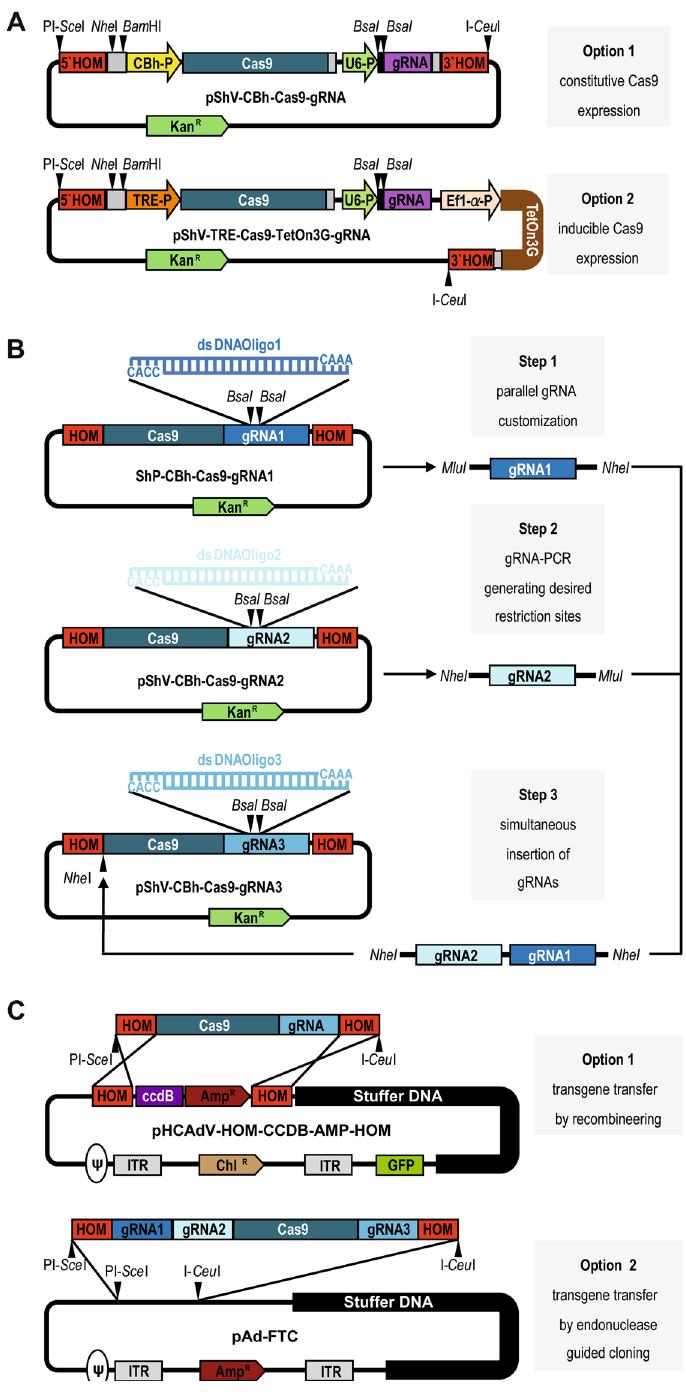
Figure 1. Plasmid toolbox for the construction of CRISPR/Cas9-HCAdV genomes. ( A ) Schematic presentation of intermediate CRISPR/Cas9 shuttle plasmids for simple gRNA manipulation and multiplexing and subsequent transfer of the customized CRISPR/Cas9 machinery into the HCAdV genome. Option 1: pShV- CBh-Cas9-gRNA for constitutive Cas9 expression. Option 2: pShV-TRE-Cas9-TeOn3G-gRNA for inducible Cas9 expression utilizing the TetOn3G system. Black arrowheads indicate unique restriction enzyme sites for insertion of further gRNA expression units. ( B ) Workflow for gRNA customization and multiplexing of the CRISPR/Cas9 machinery. Step1: Complementary annealed gRNA oligonucleotides are separately inserted between the Bsa I restriction enzyme sites resulting in pShV-CBh-Cas9-gRNA1, pShV-CBh-Cas9-gRNA2 and pShV-CBh-Cas9- gRNA3. Step 2: Customized gRNA expression units gRNA1 and gRNA2 are amplified by PCR using primers generating desired restriction enzyme sites. Step 3: gRNA1 and 2 are inserted into the respective restriction enzyme site within pShV-CBh-Cas9-gRNA1 resulting in pShV-CBh-Cas9-CBh-gRNA1- gRNA2-gRNA3. ( C ) Transfer of customized CRISPR/Cas9 transgenes into the HCAdV genomes. Option